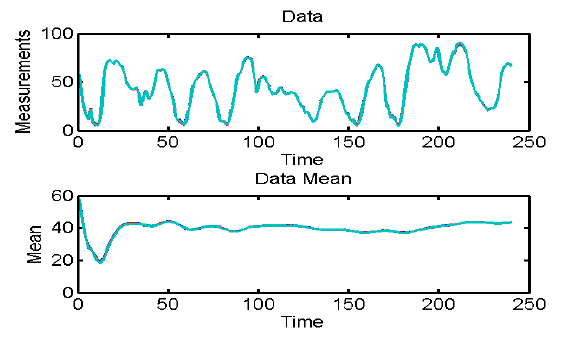
Figure 1: Measurements and mean of AQI data